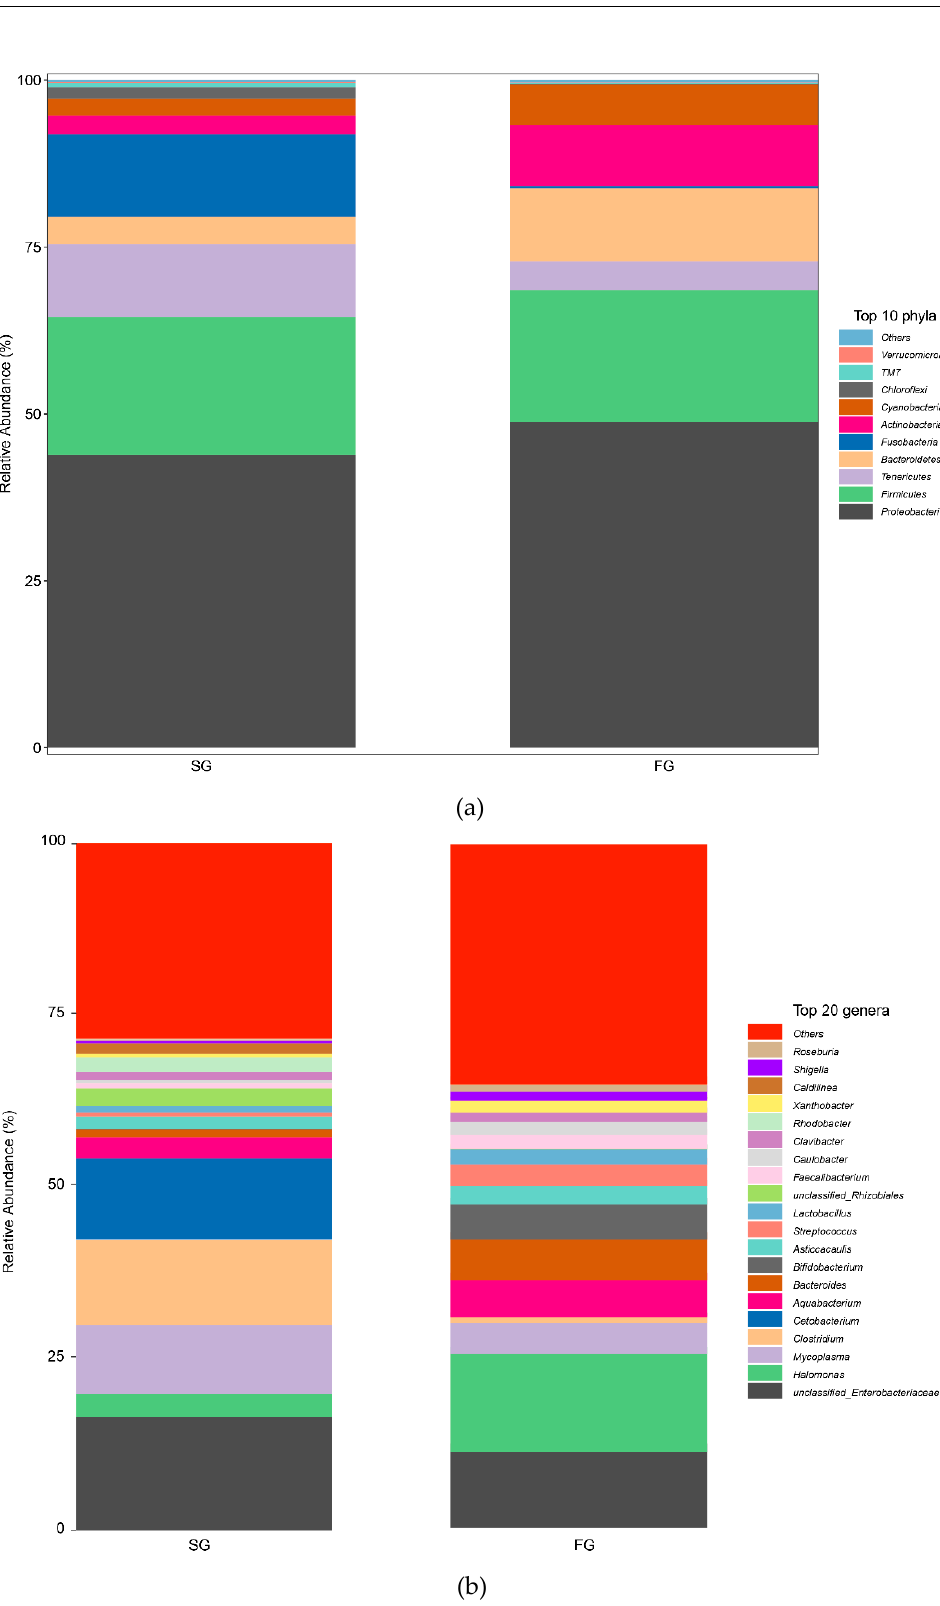
Figure 4. ( a ) Plots of the relative abundance of gut bacteria at the phylum level in the FG and SG groups of juvenile largemouth bass; ( b ) plots of the relative abundance of gut bacteria at the genus level in the FG and SG groups of juvenile largemouth bass.